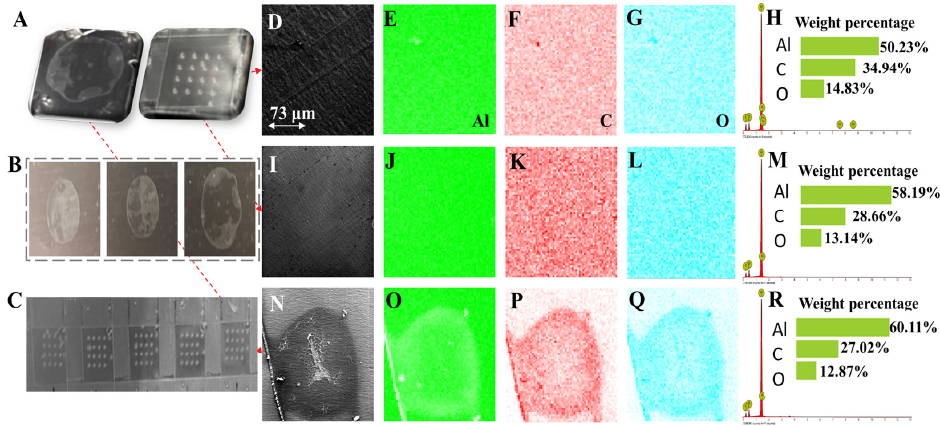
Figure 7. ( A ) The selected samples for SEM/EDS analysis; ( B ) the real image of the LIBS samples without the hole and chitosan (No HC); ( C ) the real image of LIBS samples with the hole and chitosan (HC); ( D , I ) the surface morphology of the two random selected areas in the corresponding LIBS sample of C; ( E – G ) element distribution of Al, C and O in D represented by green, red and blue, respectively; ( H ) weight percentage of Al, C and O in D; ( J – L ) element distribution of Al, C and O in I represented by green, red and blue, respectively; ( M ) weight percentage of Al, C and O in I; ( N ) the surface morphology of the random selected area in the corresponding LIBS sample of B; ( O – Q ) element distribution of Al, C and O in N represented by green, red and blue, respectively; ( R ) weight percentage of Al, C and O in N.